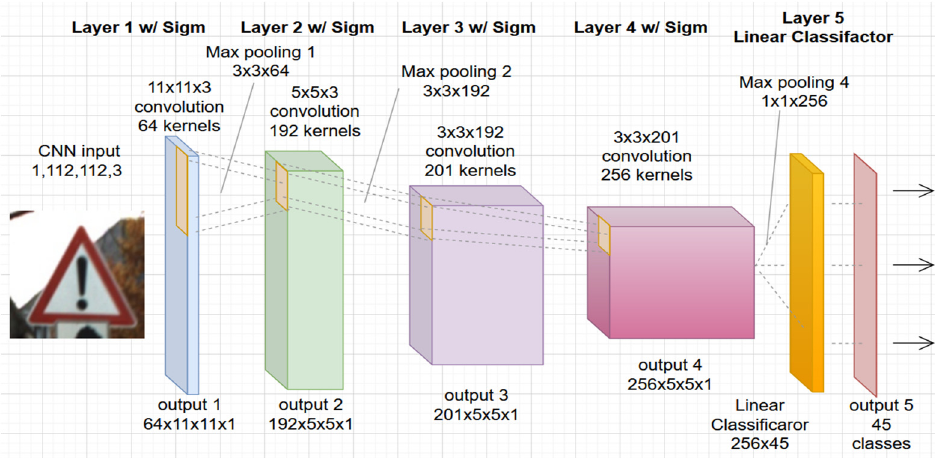
Figure 1. The architecture of the used 5-layer CNN road sign and light classification from the PRYSTINE